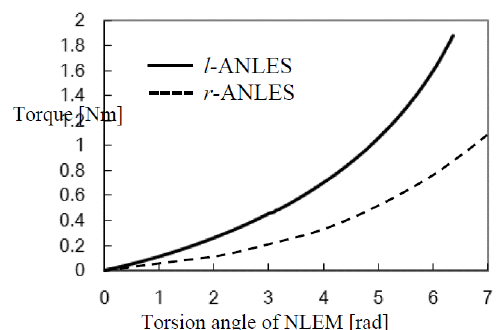
Figure 5. Non-linear elasticity of ANLES designed for elbow